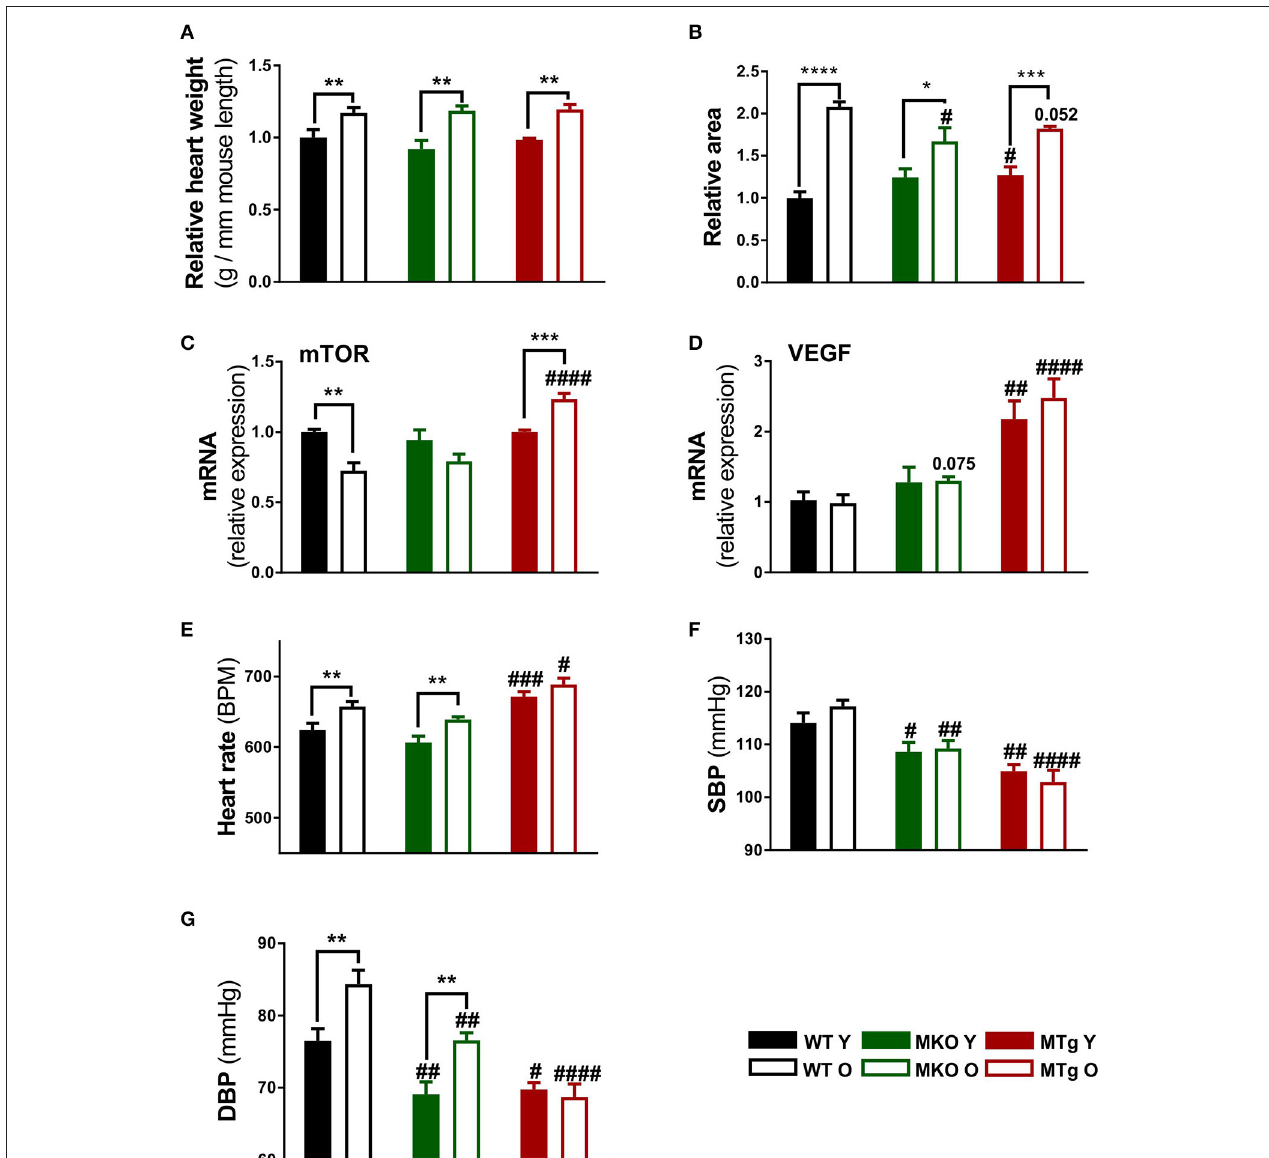
FIGURE 1 | Moderate PGC-1 α modulation reduces blood pressure. (A) Heart weight to mouse length ratios were assessed after sacrifice at 3 and 24 months of age for the young (filled bars) and old (open bars) mice, respectively ( n = 6/group). (B) Transverse heart area was measured on microscopy sections using Fiji software ( n = 4/group). Relative area refers to normalization to the area measured in WT Y animals. (C,D) Gene expression of mTOR and VEGF ( n = 6/group). (E–G) Heart rate, systolic and diastolic blood pressure were measured with BP-2000 Blood Pressure Analysis System (Visitech Systems) ( n = 10–12/group). Data are means ±